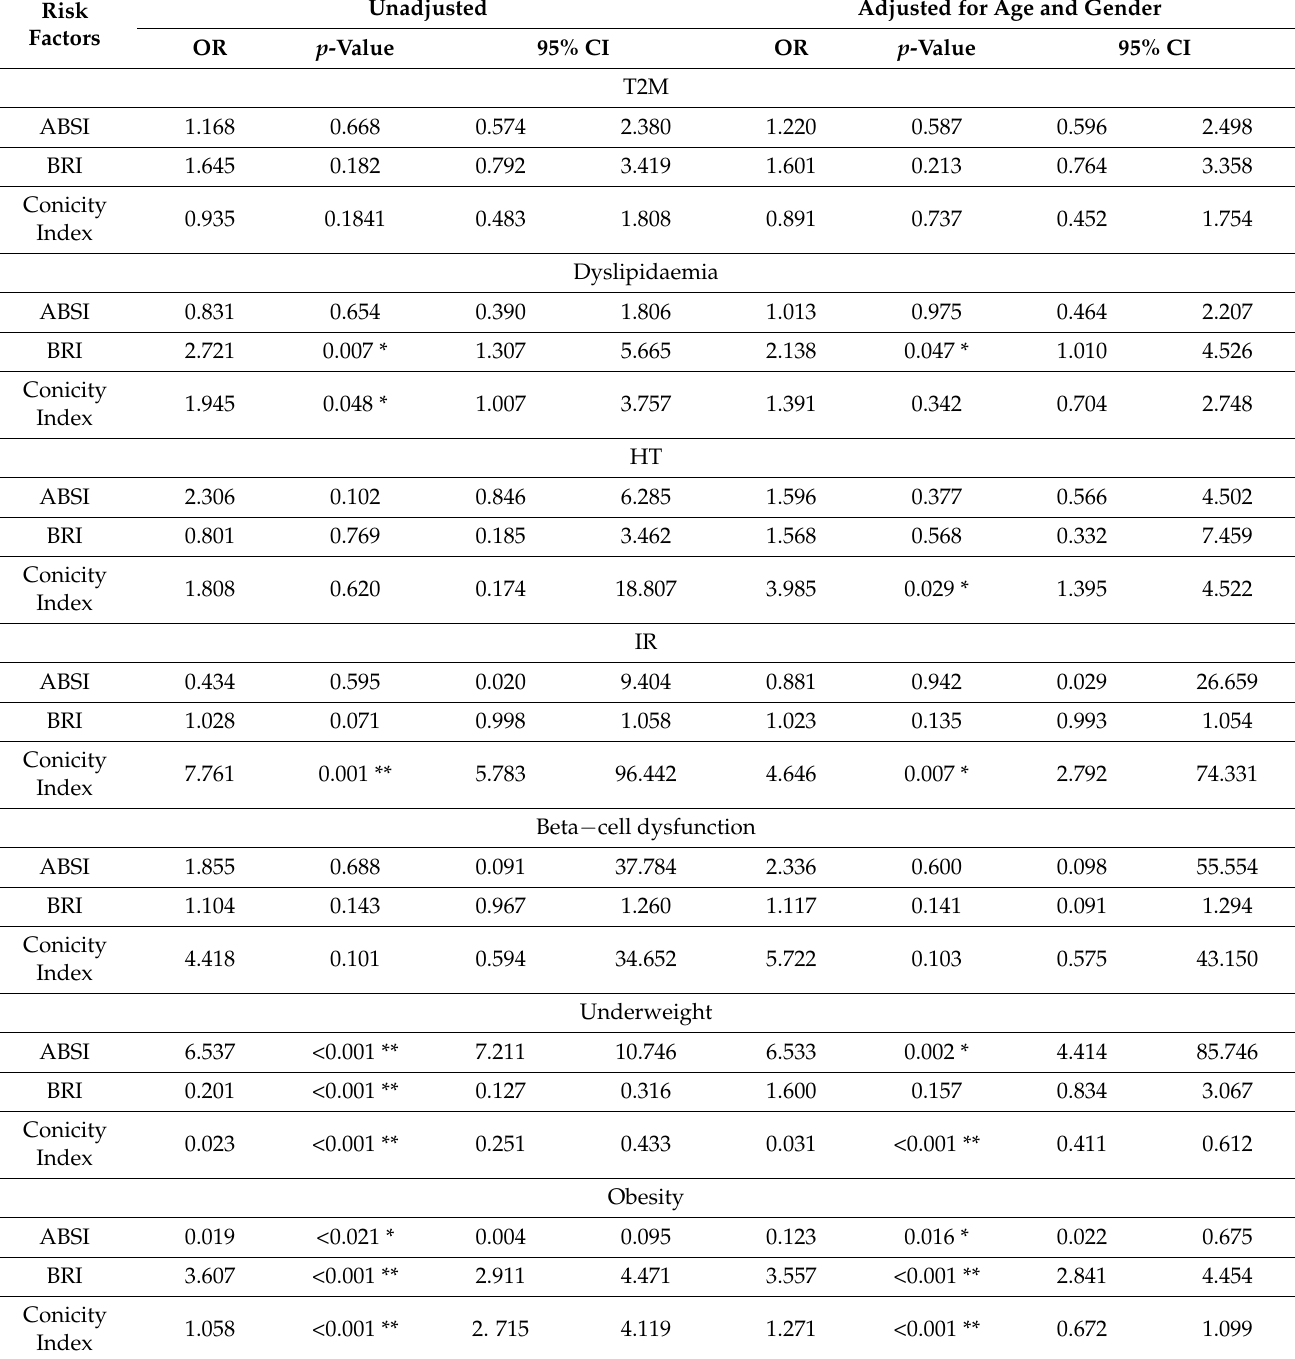
Table 4. The odds ratio (OR) and 95% confidence interval (CI) for the association of Conicity Index, BRI, and ABSI values with the prevalence of T2M, HT, and dyslipidaemia in unadjusted and adjusted for age and gender